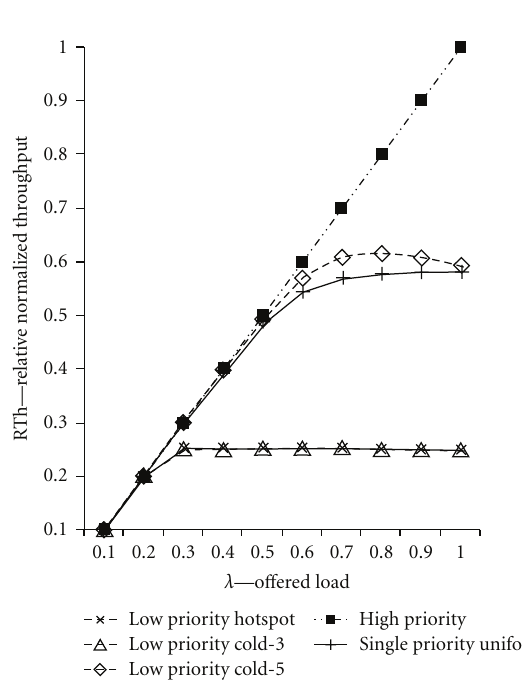
Figure 4: Relative normalized throughput of a dual-priority, double-bu ff ered, 6-stage MIN under hotspot tra ffi c at a single-layer architecture.